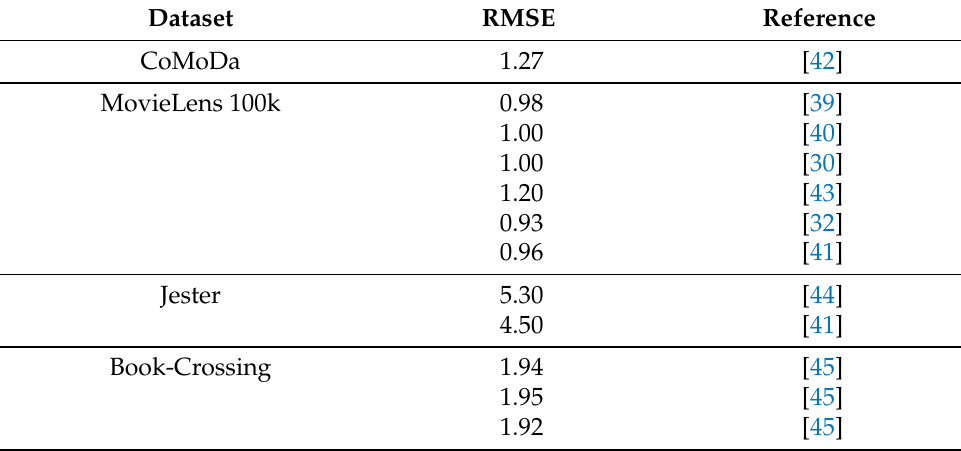
Table 3. RMSE values from the